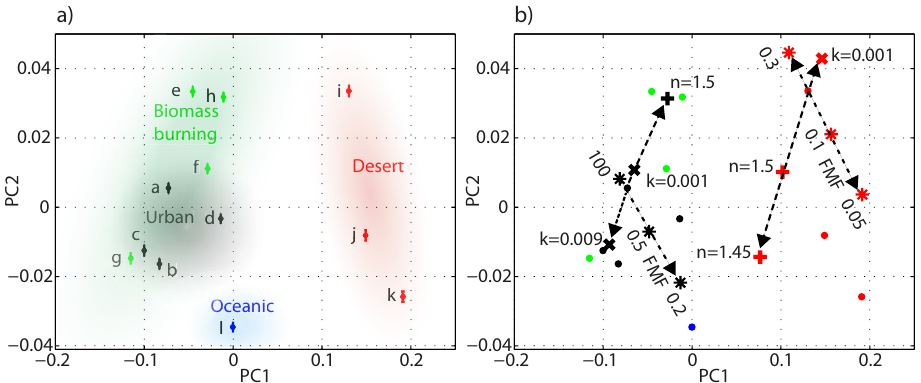
Fig. 6. (a) First two principal components of the feature vector space of the four representative aerosol types: urban (a–d), biomass burning (e–h), desert (i–k) and oceanic (l). The colored shading is meant to guide the eye in grouping the points. (b) Same as (a) but with individually varied microphysical properties of urban aerosol type a and desert aerosol type i, keeping all other parameters constant at the values given in Table 1. Varying n is indicated with markers “ + ”, varying k with markers “x” and FMF with markers